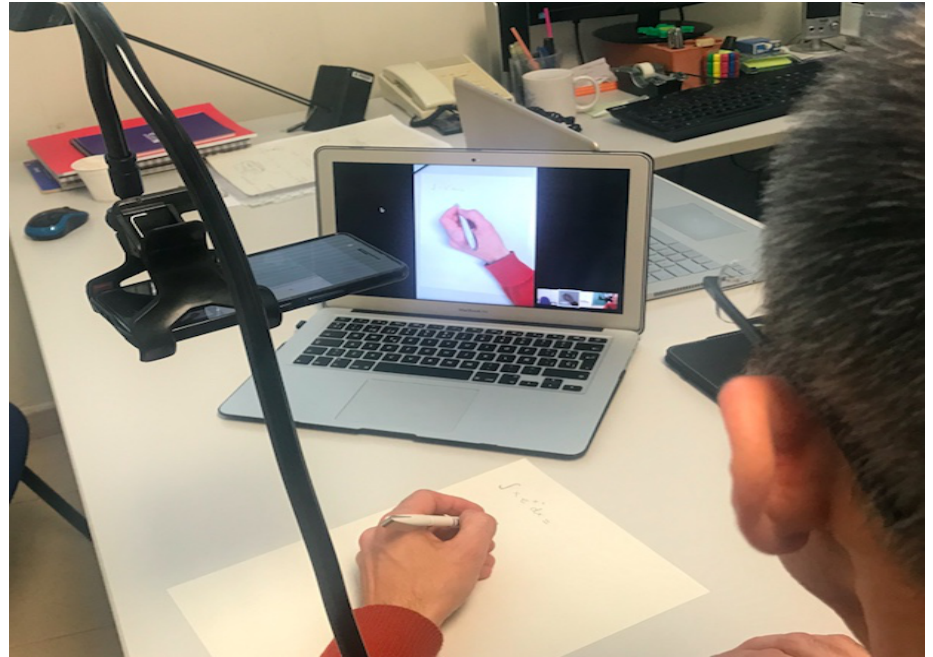
Figure 4. Office hours through videoconferencing using the smartphone by focusing on a piece of